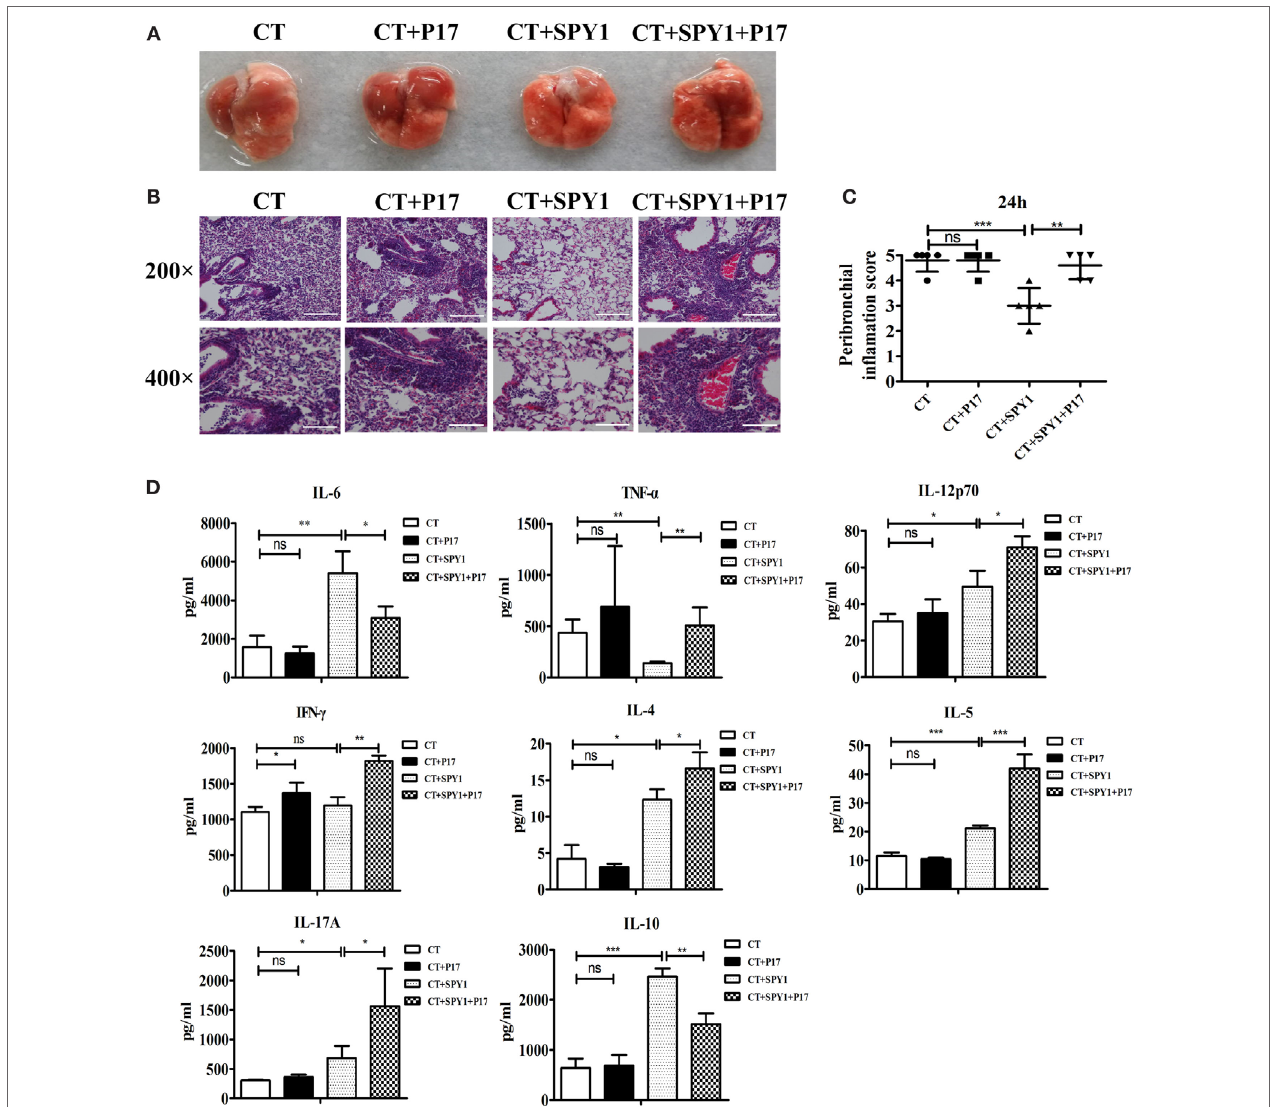
FigUre 3 | P17 treatment significantly impairs the SPY1-induced acquired protection against pulmonary injury caused by pneumococcal colonization. On day 7 after the last immunization, mice were intranasal challenged with 1 × 10 8 CFU of pneumococcal strain 19F. Mice were sacrificed and lung tissues were removed at 24 h post-intranasal infection with pneumococcal strain 19F. (a) Lungs appearance post-infection. (B) Pathological analyses were done by hematoxylin and eosin staining, with lung sections examined under light microscopy at 200 × (scale bar = 100 µm) and 400 × (scale bar = 50 µm) magnification. (c) Scores of peribronchial inflammations were semi-quantitatively graded, and data were shown as mean ± SD of scores of five mice per group. (D) Concentrations of cytokines including IL-6, TNF- α , IL-12p70, IFN- γ , IL-4, IL-5, IL-17A, and IL-10 in lung homogenates collected at 48 h post-infection were detected by enzyme- linked immunosorbent assay, and the data were shown as mean ± SD (each experiment was individually performed three times). * p < 0.05; ** p < 0.01; *** p <